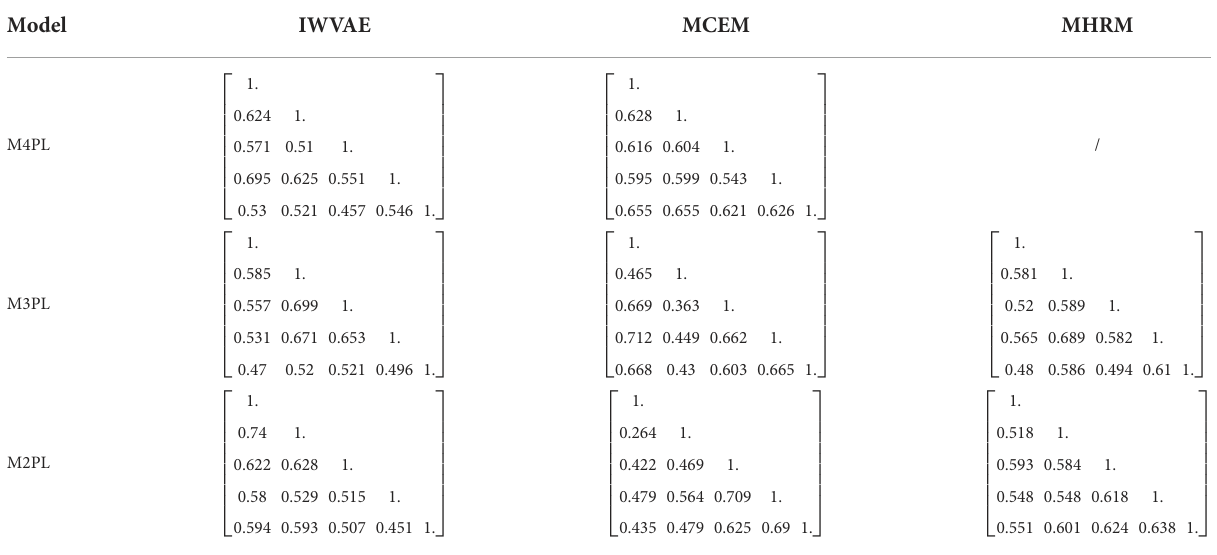
TABLE 9 Comparison of estimated R θ from different models on MST dataset. Model IWVAE MCEM